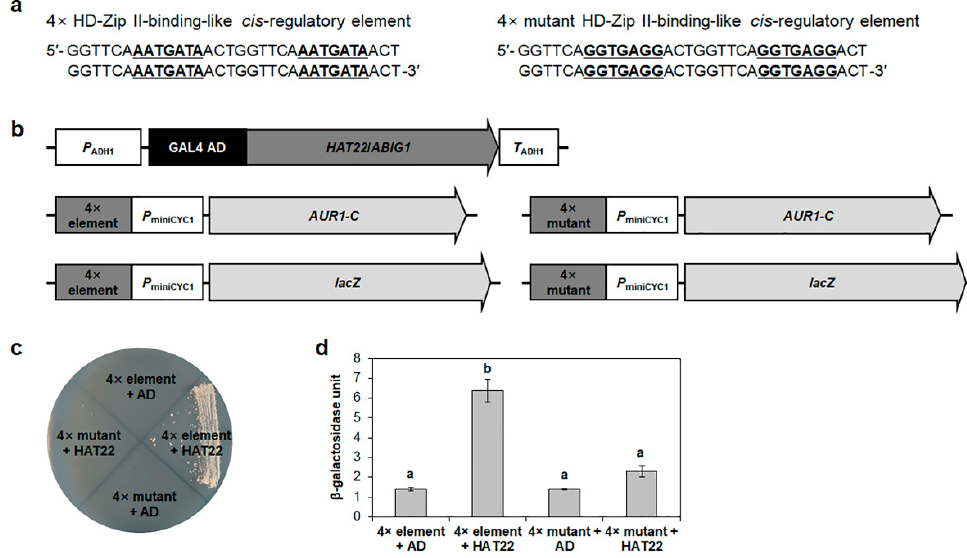
Figure 8. Confirmation of binding of HAT22/ABIG1 to HD-Zip II-binding-like cis -regulatory element in yeast. ( a ) Sequences of tandem repeats of HD-Zip II-binding-like cis -regulatory element or mutant HD-Zip II-binding-like cis -regulatory element for yeast one-hybrid assay. Consensus sequences are underlined. ( b ) Schematic maps of vectors for yeast one-hybrid assay. AUR1-C and lacZ reporter genes were used for yeast one-hybrid assay. ( c ) Yeast growth assay. Yeast transformants were grown on SM-Leu/-Ura containing 150 ng/mL AbA. ( d ) Quantitative β -galactosidase ONPG assay. β -Galactosidase activities were used for binding activity quantification. Data are shown as means ± S.D. ( n = 3). Different letters display significant differences ( p < 0.05). In ( c , d ), GCC box and empty vectors were used for positive and negative controls, respectively.